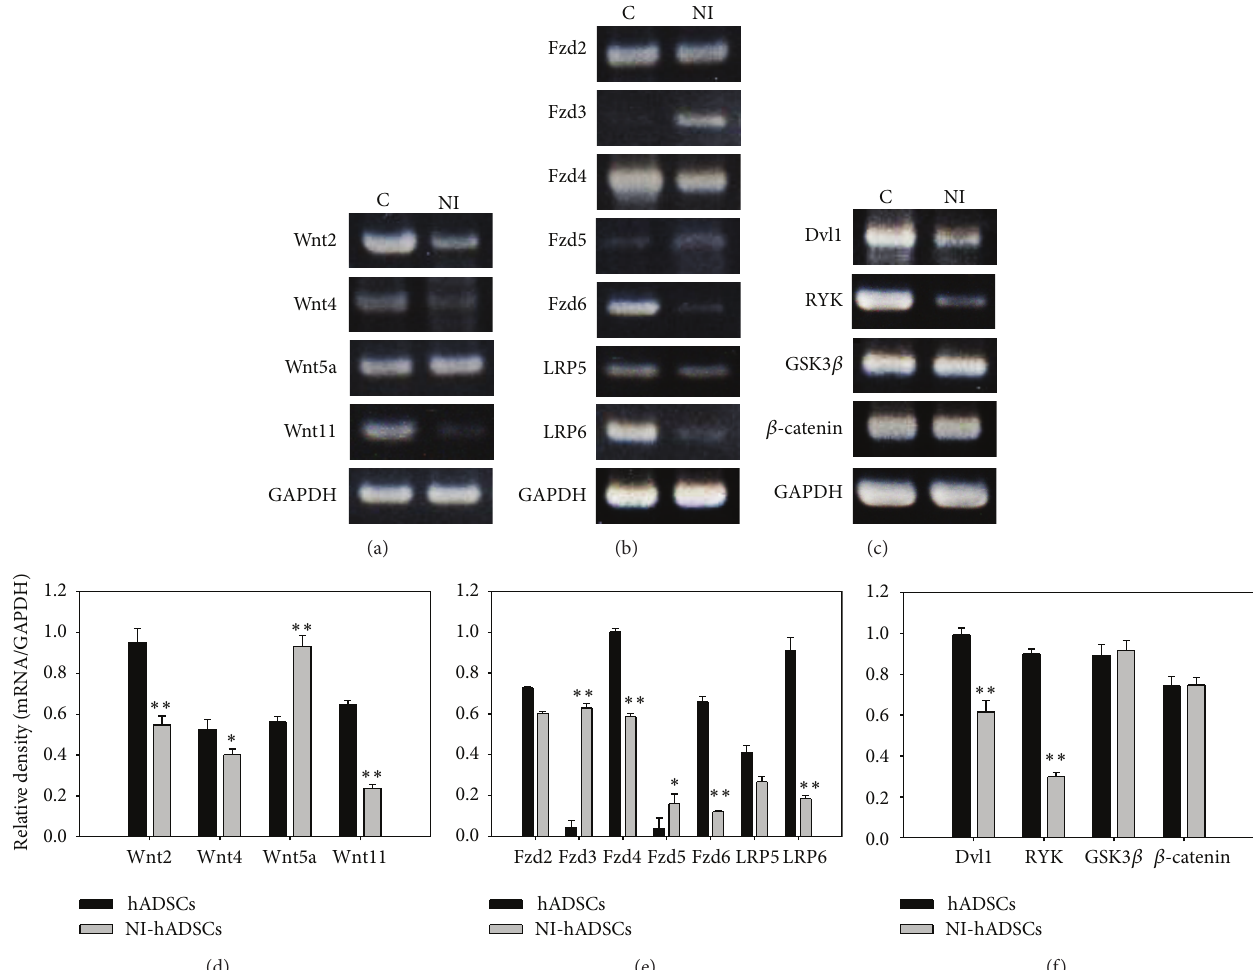
Figure 1: RT-PCR analysis of Wnt pathway-related genes. We demonstrated Wnt genes and Wnt pathway genes by RT-PCR (a–c) and quantified the results (d–f). To figure out the effect of Wnt signal in neural differentiation of stem cell, RT-PCR study was performed using primers of Wnt signal-related genes. (a and d) Most Wnt genes are overexpressed in primary hADSCs whereas the expression of Wnt5a is increased in NI-hADSCs. (b and e) Except Fzd3 and Fzd5, all Wnt receptor and coreceptor genes that are expressed in hADSCs are suppressed in NI-hADSCs. The expression of Fzd3 and Fzd5 is shown in NI-hADSCs. (c and f) The expression of Dvl1 and RYK is decreased in NI- hADSCs. Also, there is no change in the expression of either GSK3 𝛽 protein or 𝛽 -catenin. GAPDH was used as a control. The RT-PCR assay was repeated five times independently of different cells and the representative data are shown. The intensity of each gene was normalized to GAPDH. ∗ 𝑃 < 0.05 , ∗∗ 𝑃 < 0.01 compared with the primary hADSCs. C, primary hADSCs; NI,